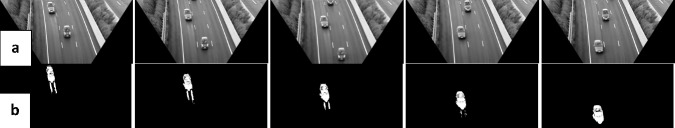
Detection of vehicle in lane 1 of the high way a) Remapped by MIPM b) Detected vehicle in lane 1 by GMM.